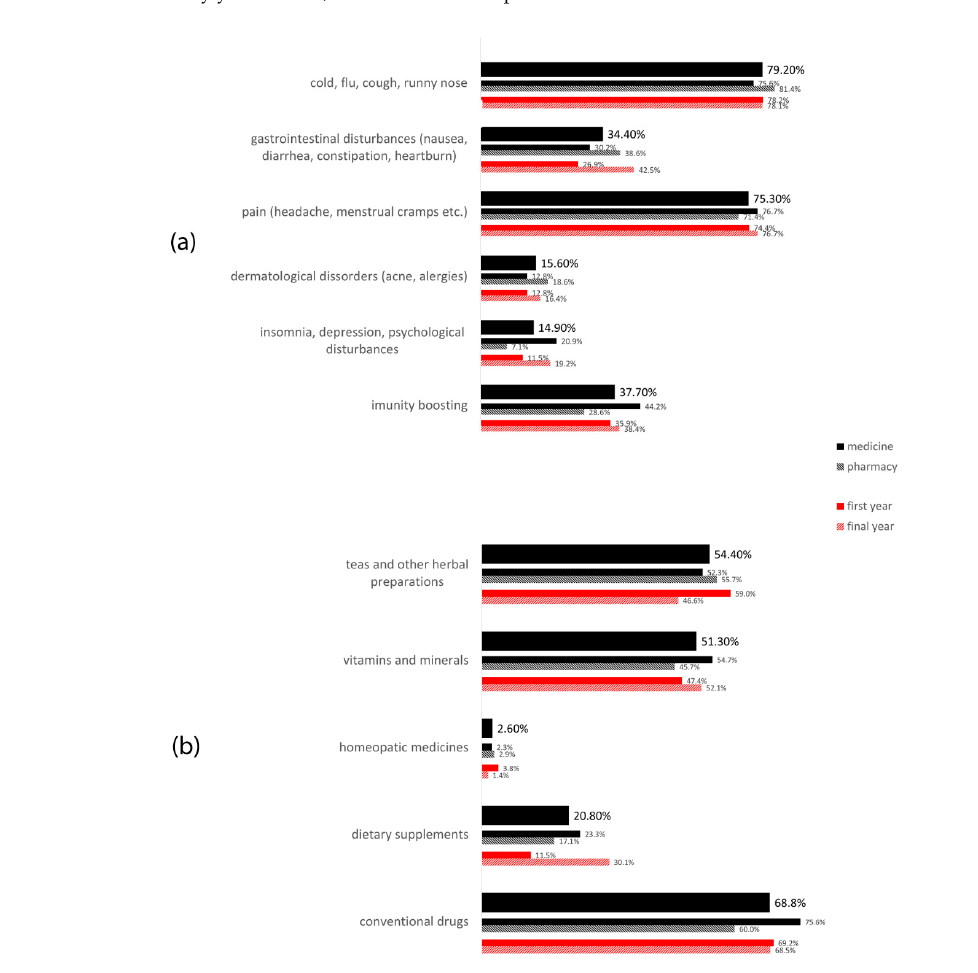
Figure 2. Identified indications ( a ) and types of drugs ( b ) used for self-medication.